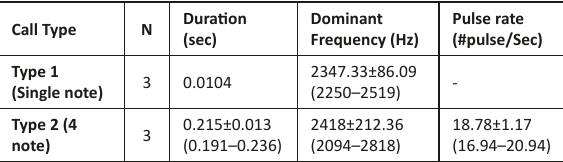
Table 1. Advertisement Call characteristics of Rhacophorus lateralis. Values are Mean ± SE and the range is given in parenthesis. Call Type